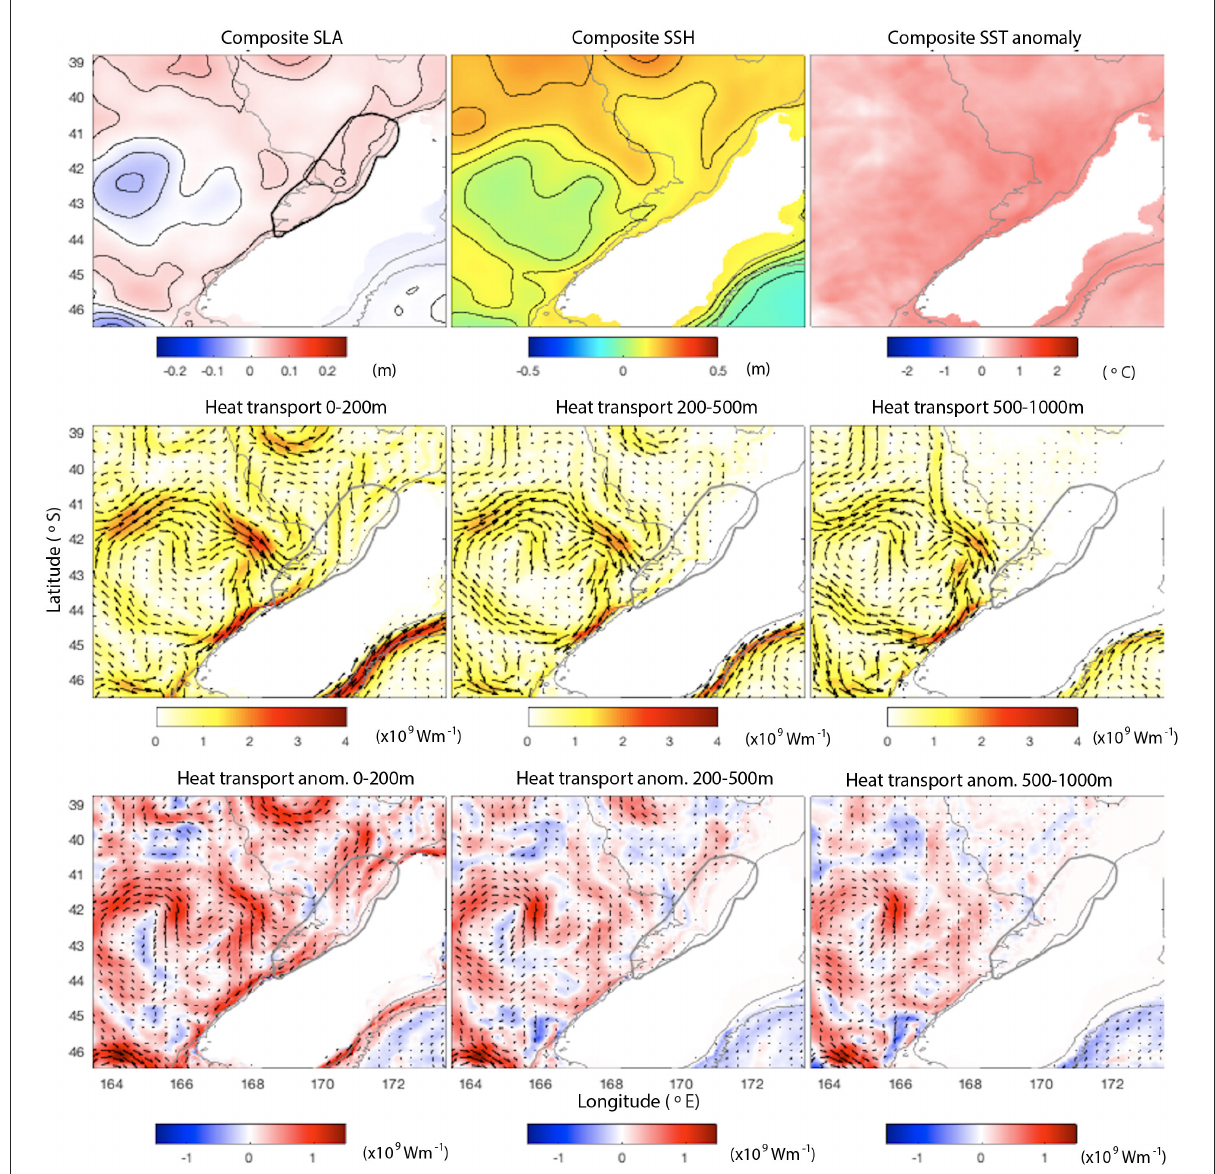
FIGURE13 (Top) : Ensemble means of SSH anomaly, SSH and SST anomaly averaged over the 4 days leading up to all 34 MHW events in the Hokitika region. (Middle) : Ensemble means of depth-integrated heat transport averaged over the 4 days leading up to MHW events from 0 to 200, 200 to 500, and 500 to 1,000 m (Wm − 1 ). (Bottom) : Ensemble means of depth-integrated heat transport anomalies (Wm − 1 ). Gray lines show the 100 and 1,000 m bathymetry